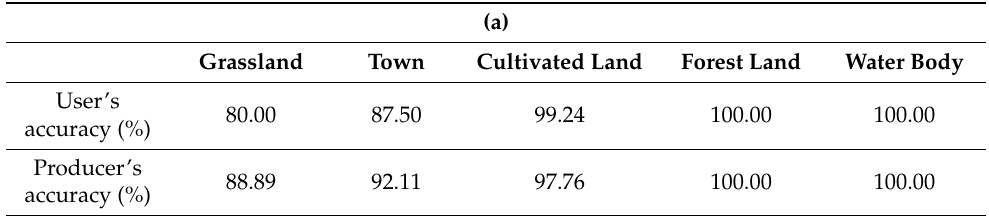
Table 5. ( a ) Classification accuracy evaluation table for different feature types; ( b ) Classification accuracy evaluation table for maize, rice, and soybeans.